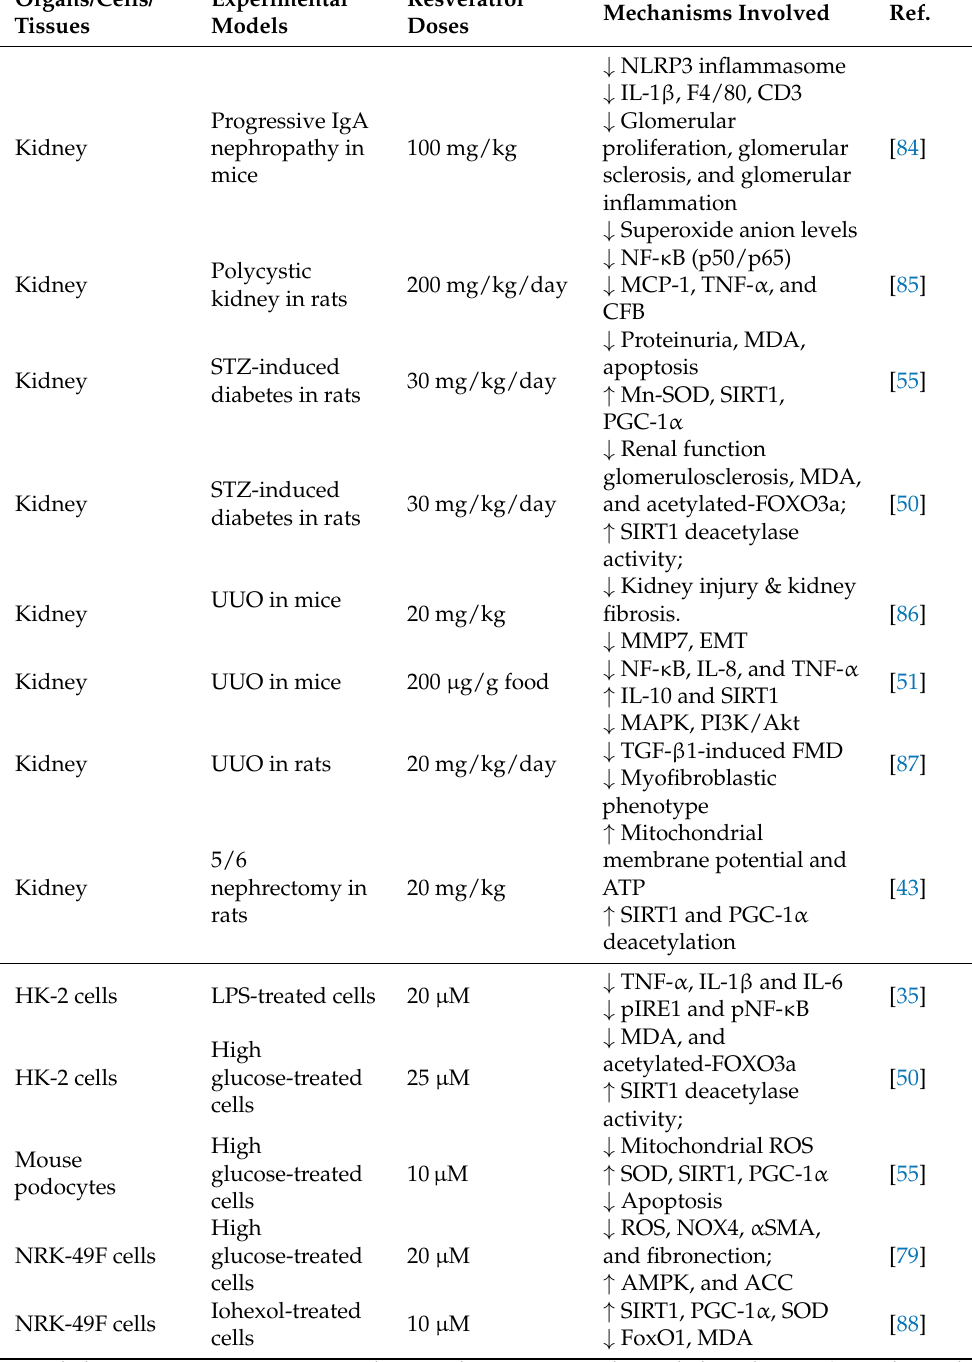
Mechanisms Involved